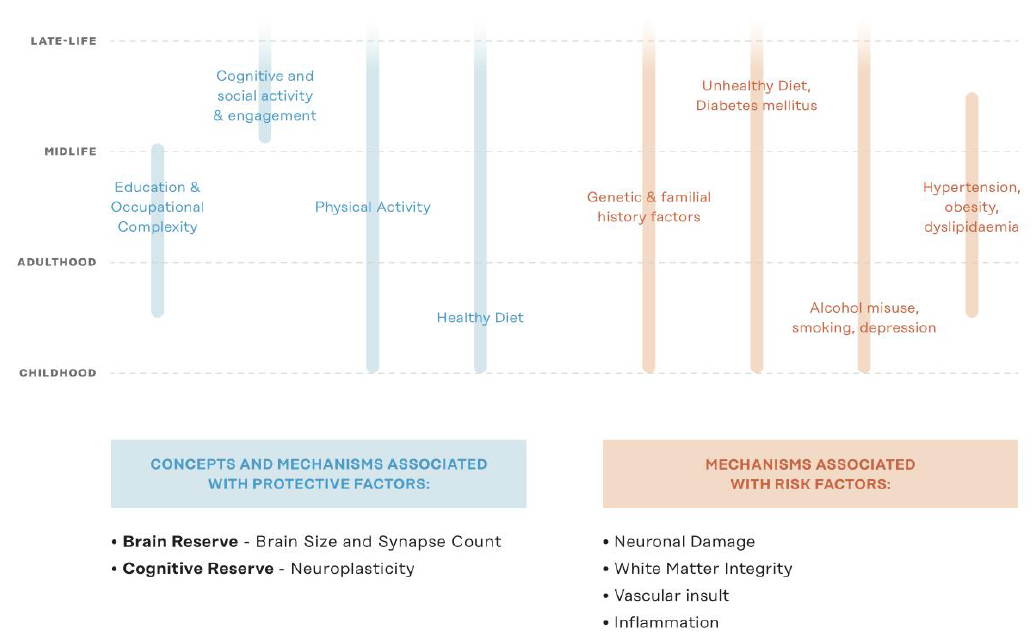
Figure 1. Lifespan protective and risk factors for ADRD. ADRD = Alzheimer’s disease & related dementias; Figure adapted from Kivipelto et al., 2018 [19].